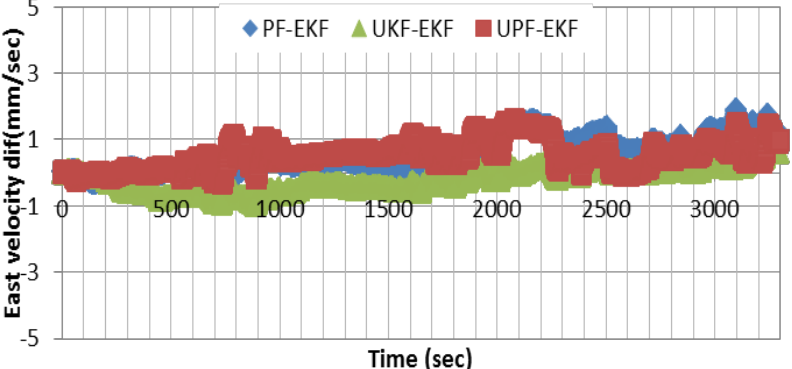
Figure 4. Velocity estimation errors.